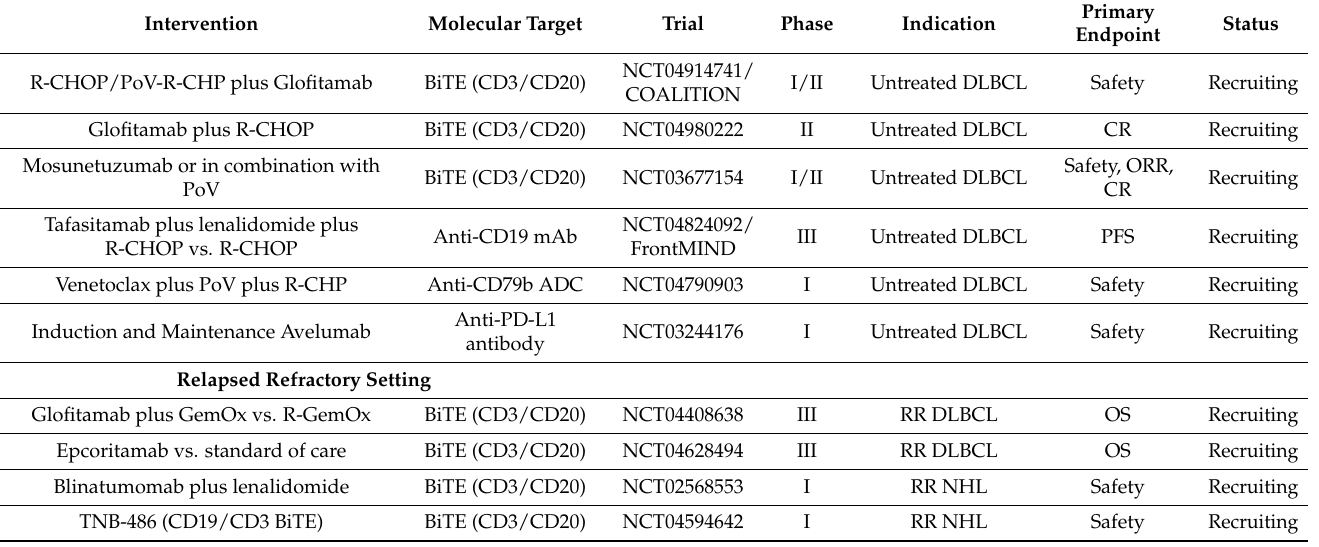
Table 3. Selected ongoing trials of Immunotherapy in